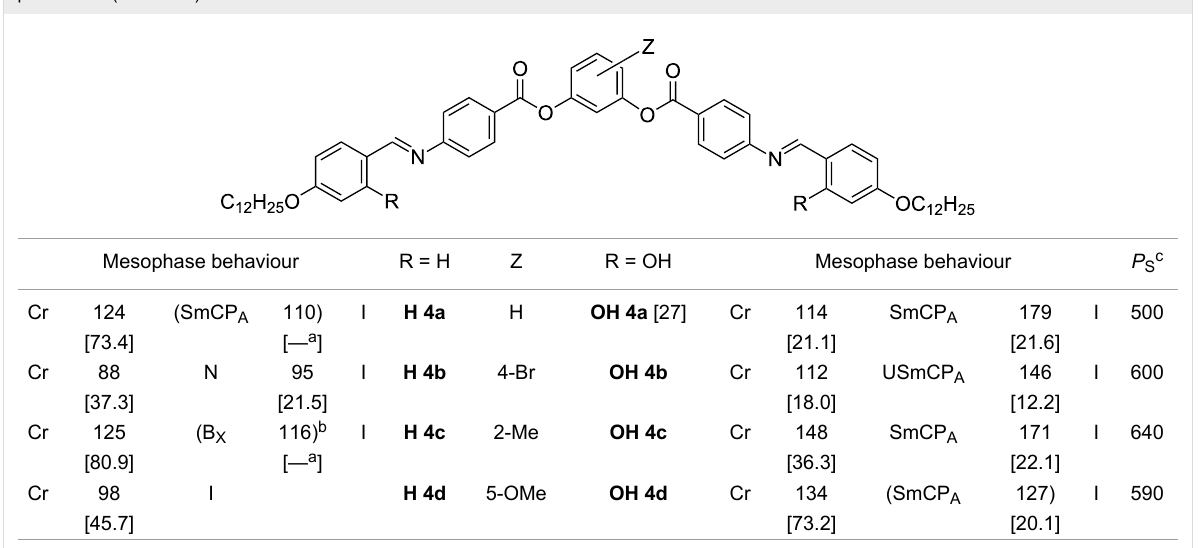
Table 4: Mesophase behaviour, transition temperatures (°C) and -enthalpies [kJ/mol] of compounds OH 4 (on the right) and corresponding com- pounds H 4 (on the left).